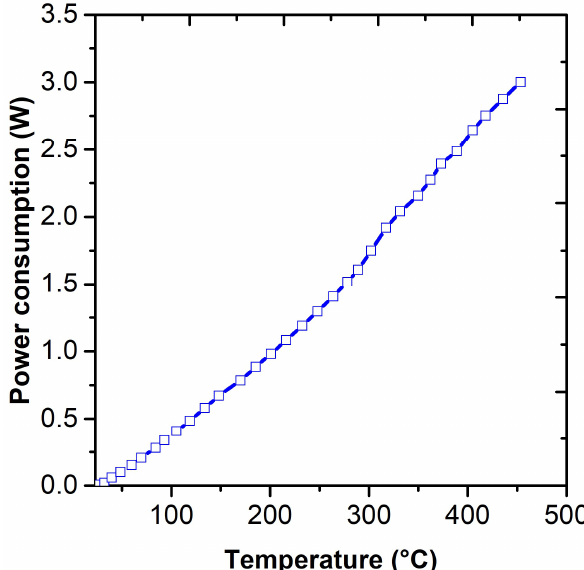
Figure 2. Dependence of the power consumption on the temperature.